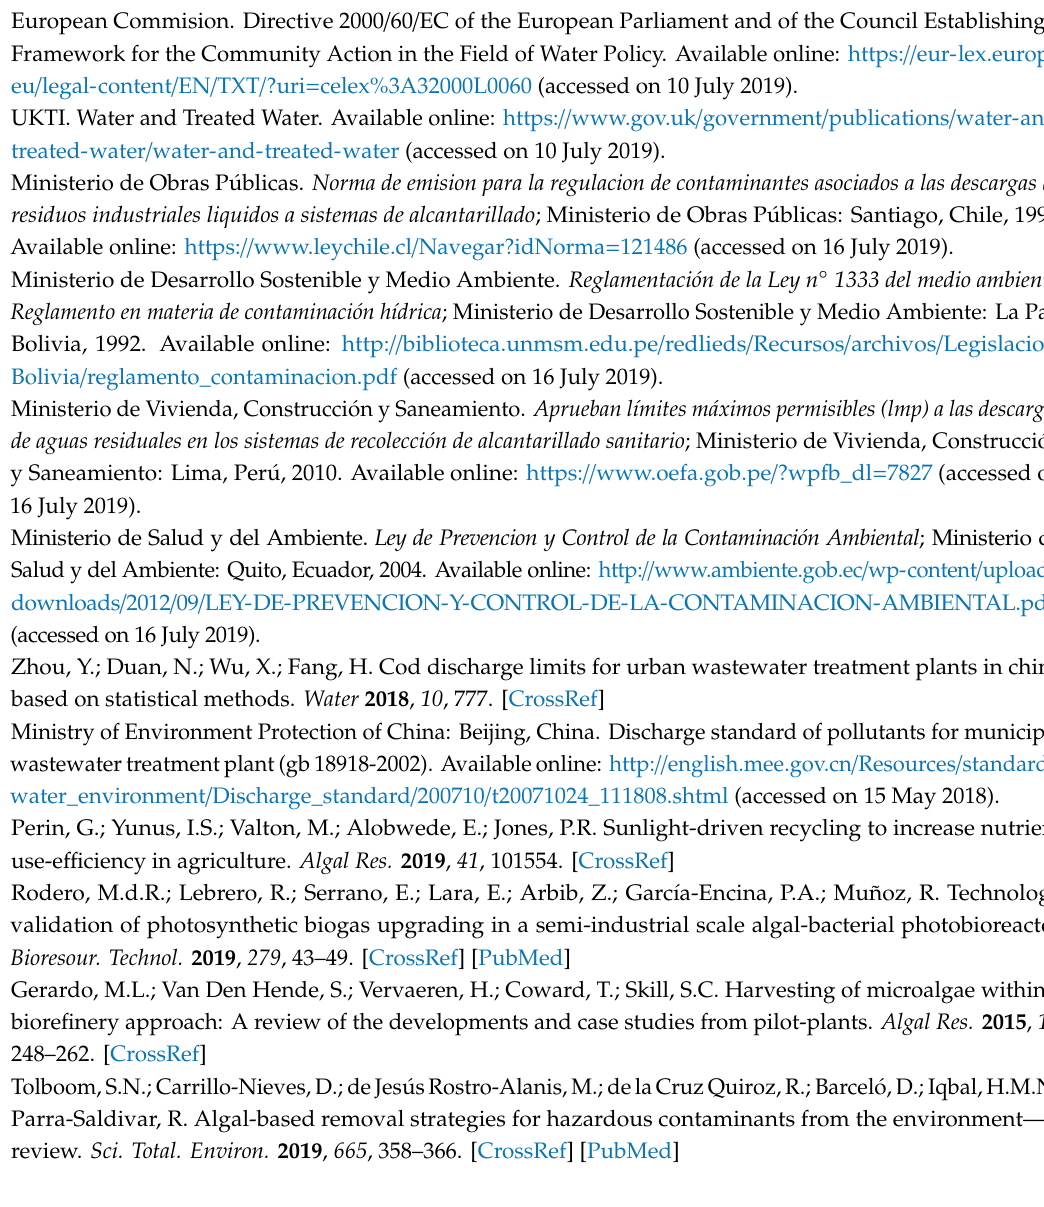
Table S1: Results of GLM + ANOVA test on crossed factors (time of experiment and waste stream) on the variables; dry weight, ammonium and phosphorus uptake and intracellular N and P. Significance is shown by; ***: p < 0.001, **: p < 0.01 and *: p < 0.05. Results of post hoc Tukey tests indicating levels of significance. C: Control; AQW: Aquaculture Waste; ADMW: AD Municipal Waste; AW: Agricultural